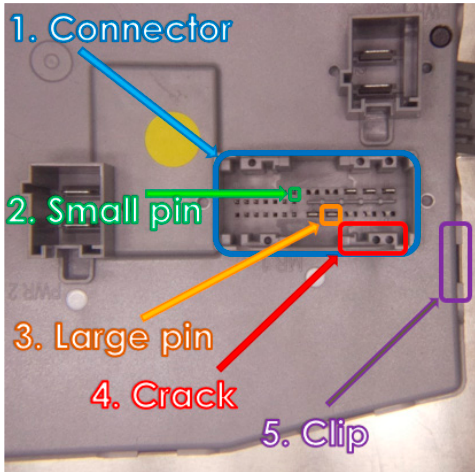
Figure 4. Some analyzed components on an Electronic Control Unit (ECU).